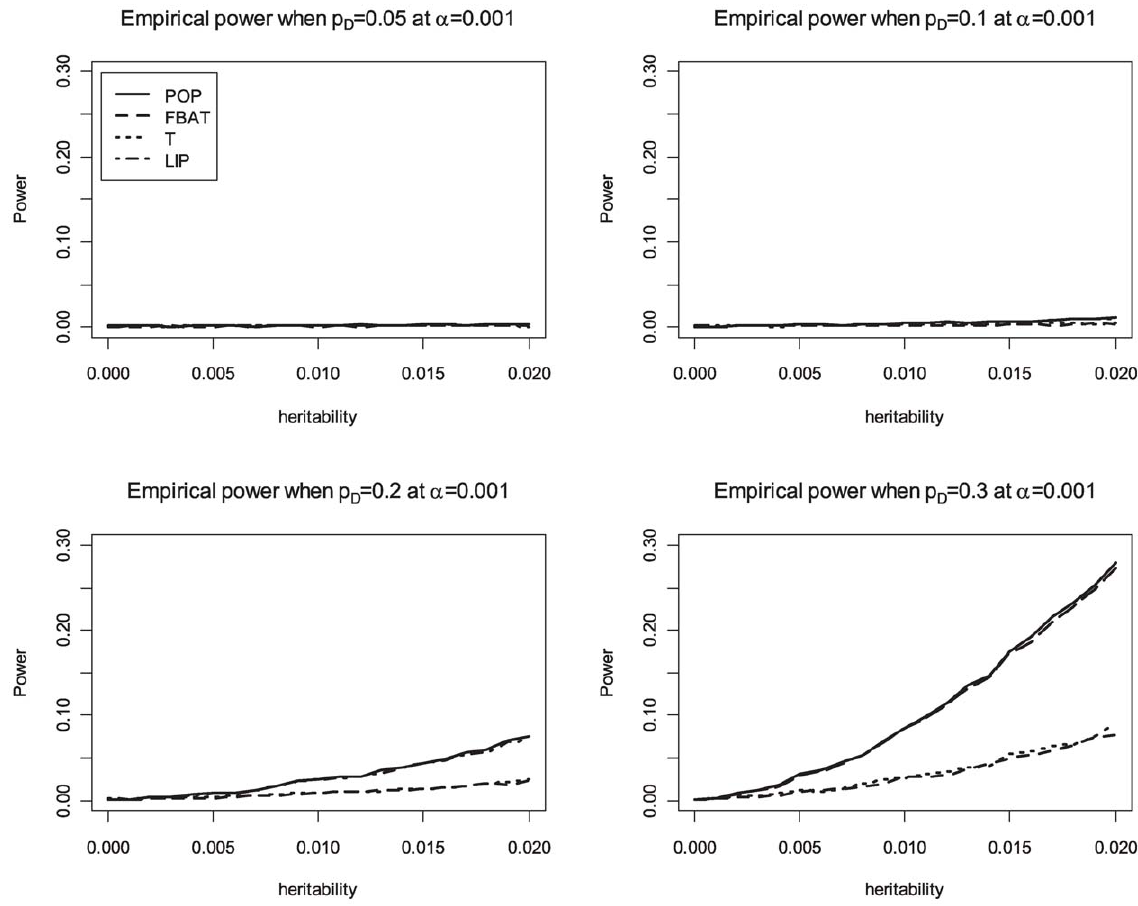
Figure 3. Empirical power at 0.001 significance level for recessive disease. POP is the empirical power of the standard population-based method. T is the empirical power of the Wald test based on the conditional mean model [22] for between-family components. LIP is the empirical power of the combined p-values with Liptak’s method. In this figure, FBAT and T are completely overlapped.